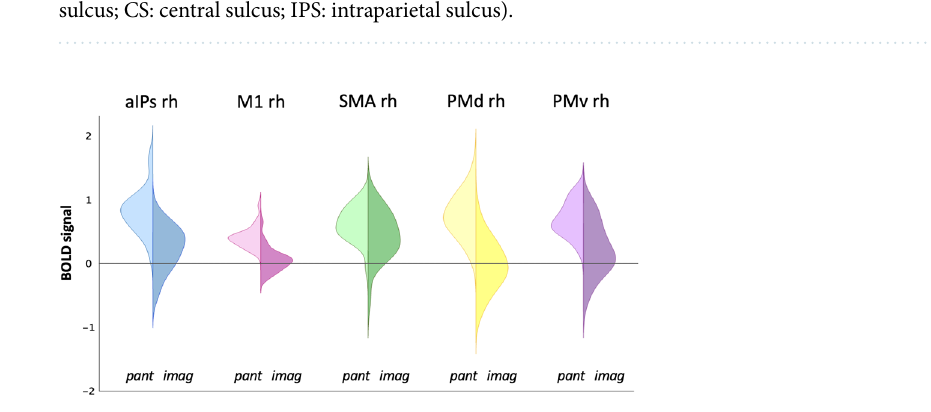
Figure 2. Group whole-brain results. Superimposition of the group activation maps resulting from the pantomimed grasping > fixation (in red) and the imagined grasping > fixation t-contrasts (in green) and average location of right hemisphere regions of interest (ROIs). Overlapping activated right brain regions across the two conditions are displayed in yellow. Maps are overlaid into an inflated Conte69 atlas 31 of the right hemisphere. Average location of aIPs (anterior intraparietal sulcus area), PMv (ventral premotor area), PMd (dorsal premotor area), SMA (supplementary motor area), and M1 (primary motor cortex) is represented through black edges and labelled arrows. Anatomical landmarks are also reported (SFS: superior frontal sulcus; IFS: inferior frontal sulcus; CS: central sulcus; IPS: intraparietal sulcus).